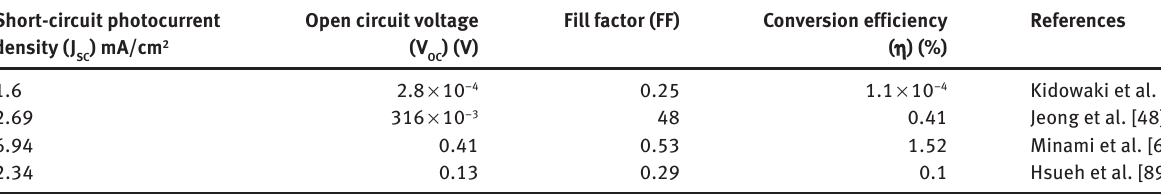
Table 2: Photovoltaic properties of CuO-ZnO nanocomposite as solar cell. Short-circuit photocurrent density (J ) mA/cm SC